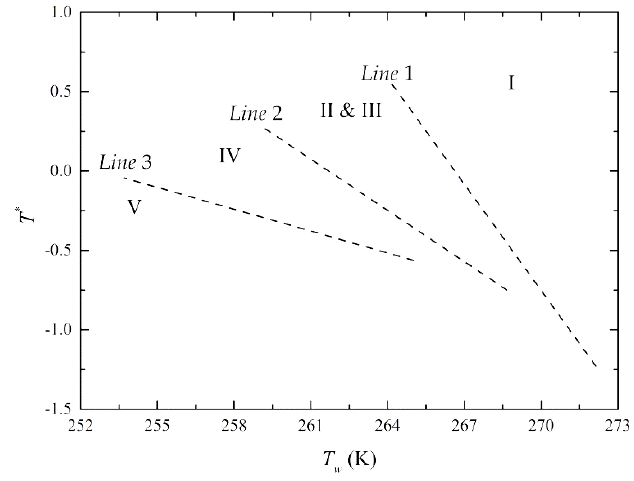
Figure 1. Illustration of frost morphology on the flat plate from Wu et al. [16] . I: super-cooled wa- ter droplets, II: irregular crystals, III: flake crystals, IV: needle and pole crystals, and V: feather crystals.